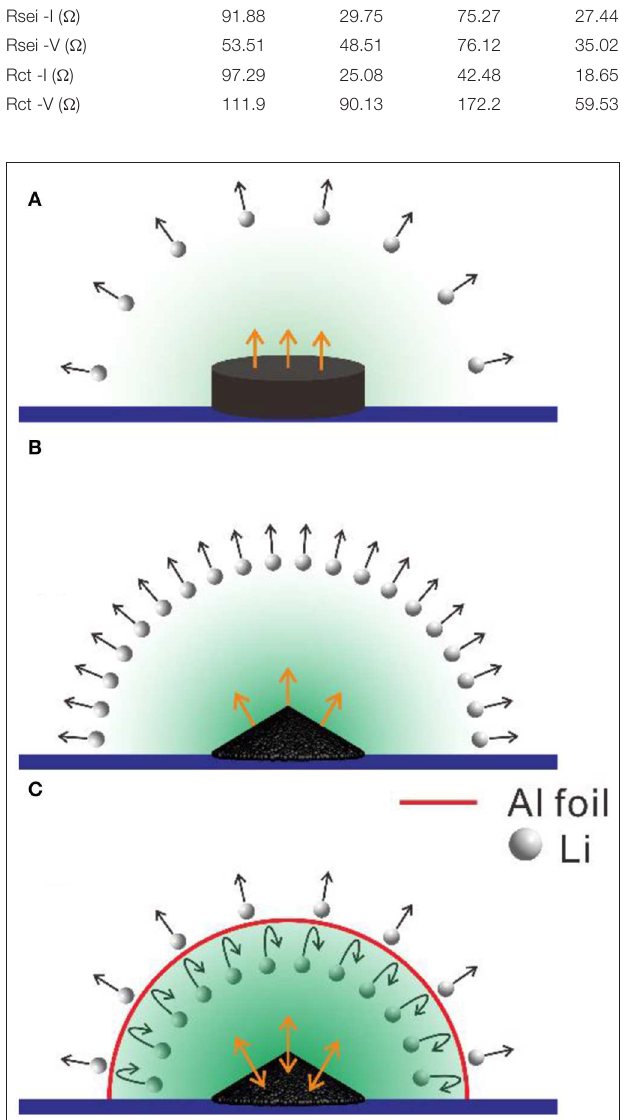
FIGURE 8 | Schematic diagram of lithium evaporation from LiBC during high-temperature treatment under different conditions. (A) pellet, (B) power, and (C) power wrapped in Al